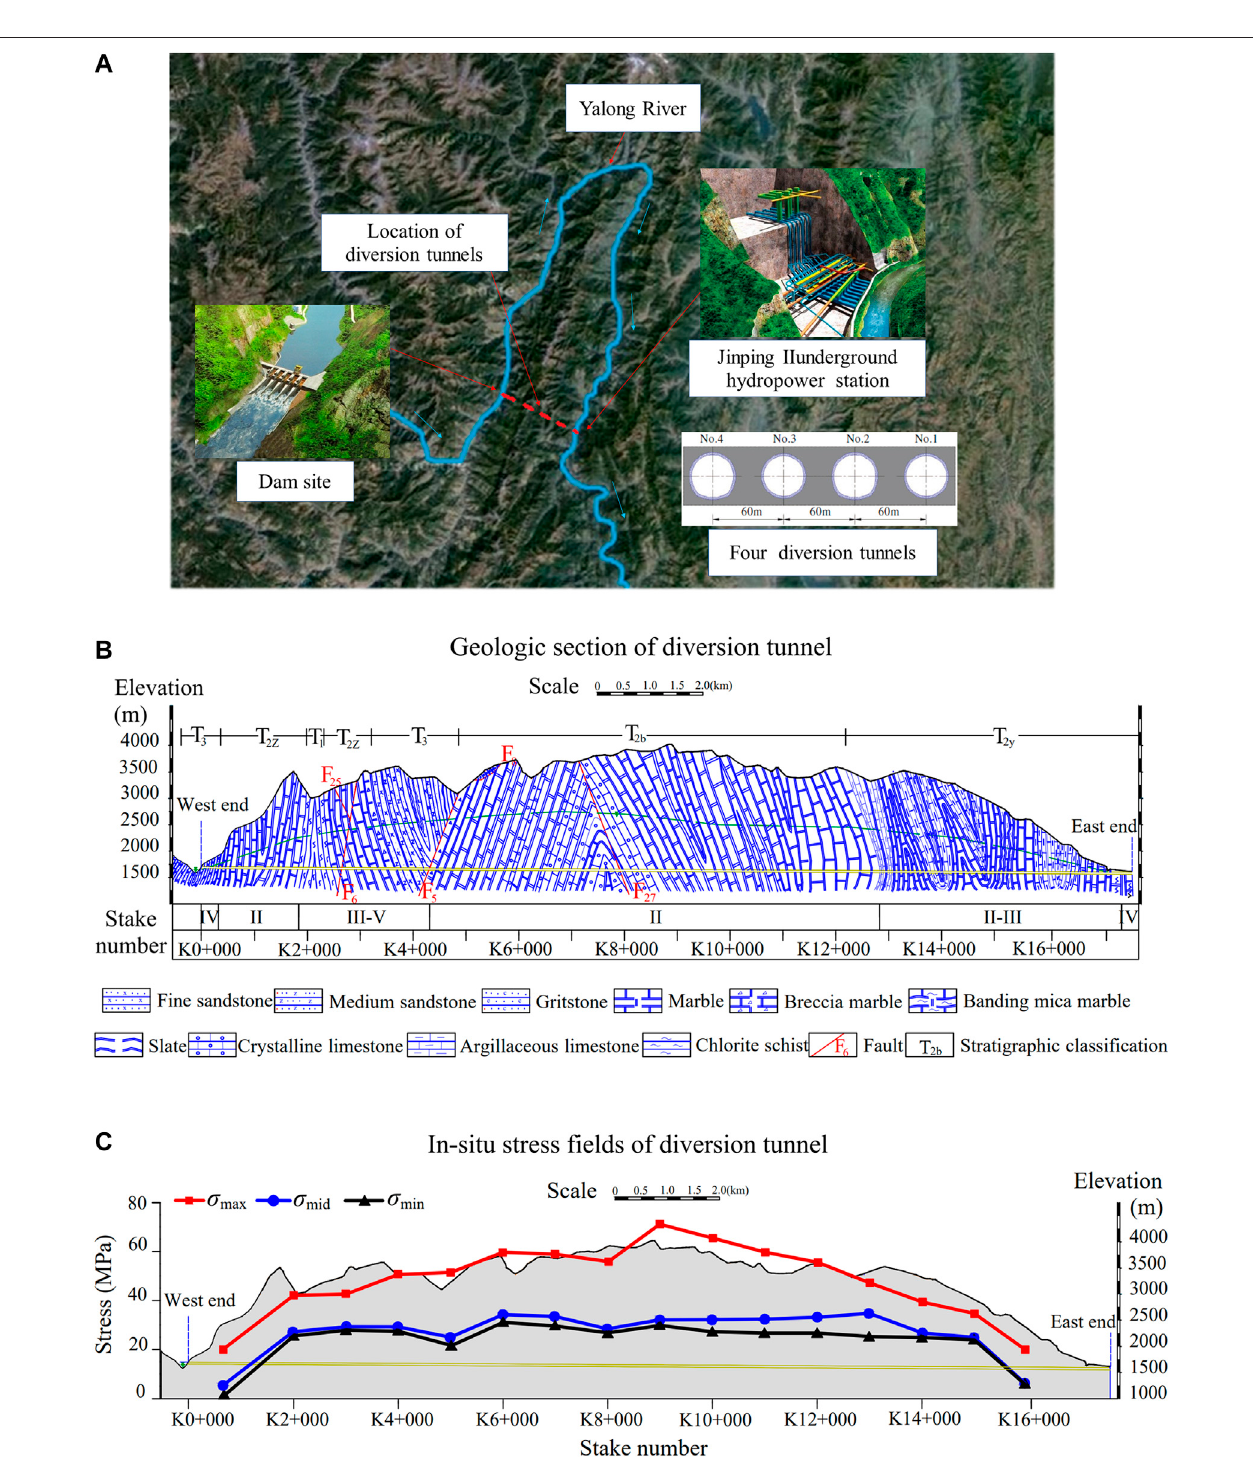
FIGURE 1 | Geological Conditions. (A) Location of the diversion tunnels at Jinping II hydropower, (B) Geologic section of the diversion tunnels at Jinping II hydropower project, (C) In-situ stress fi elds of the diversion tunnels at Jinping II hydropower project.